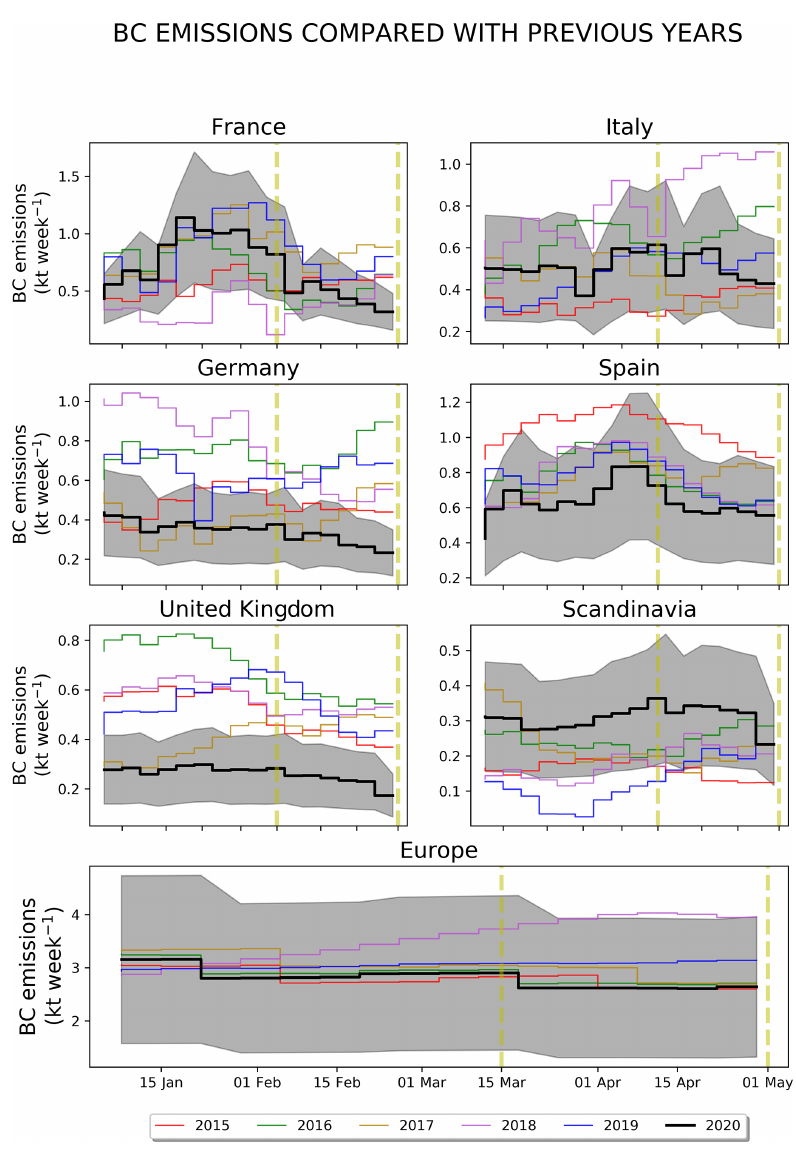
Figure 9. Posterior BC emissions in the most highly affected European countries (France, Italy, Germany, Spain and UK), Scandinavia and Europe by the COVID-19 pandemic (2020). Posterior BC emissions for every year since 2015 are also plotted with the same temporal resolution to show changes in BC emissions characteristics during the 2020 COVID-19 pandemic. The grey shaded area corresponds to the BC emission uncertainty, while the vertical dashed yellow lines correspond to the beginning and end of the 2020